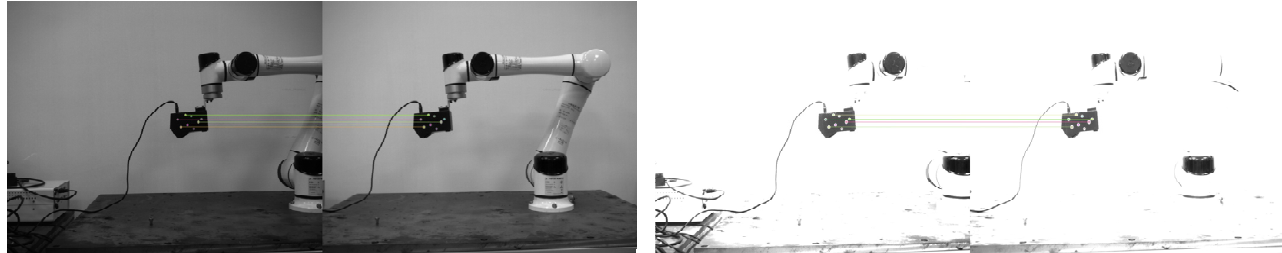
Figure 11. Positioning images with exposure times of 400 µs and 3200 µs.